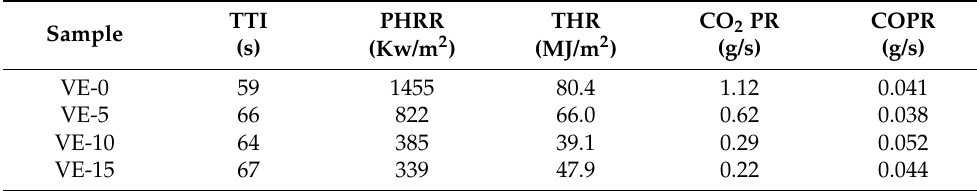
Figure 6. ( a ) Heat release rate of VE composites, ( b ) total heat release of VE composites. Table 4. Cone calorimetry data of VE composites.